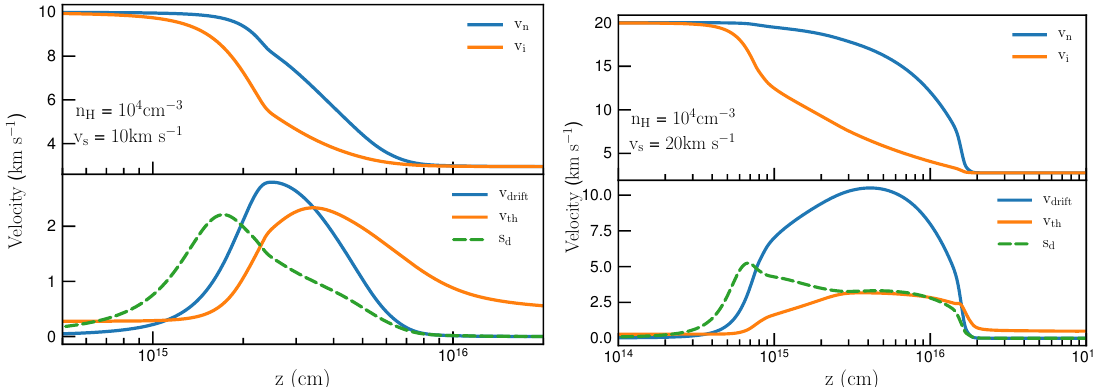
Figure 30. Velocity profiles of neutral ( v n ) , ion and charged grains ( v i ), and their relative velocity v i ) in the C-shocks for v s = 10kms − 1 (left) and 20kms − 1 (right). The dashed line shows ( v drift = v n − the drift parameter s d = v drift / v th which is dimensionless. The drift velocity increases with the shock velocity, but s d is slightly changed due to an increased thermal velocity. From Hoang and Tram